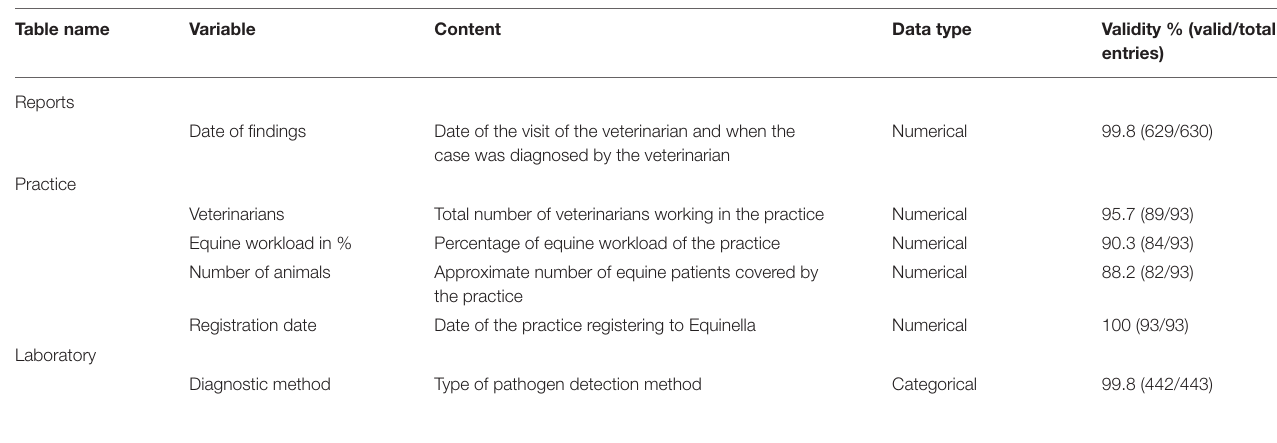
TABLE 1 | List of Equinella parameters assessed for data